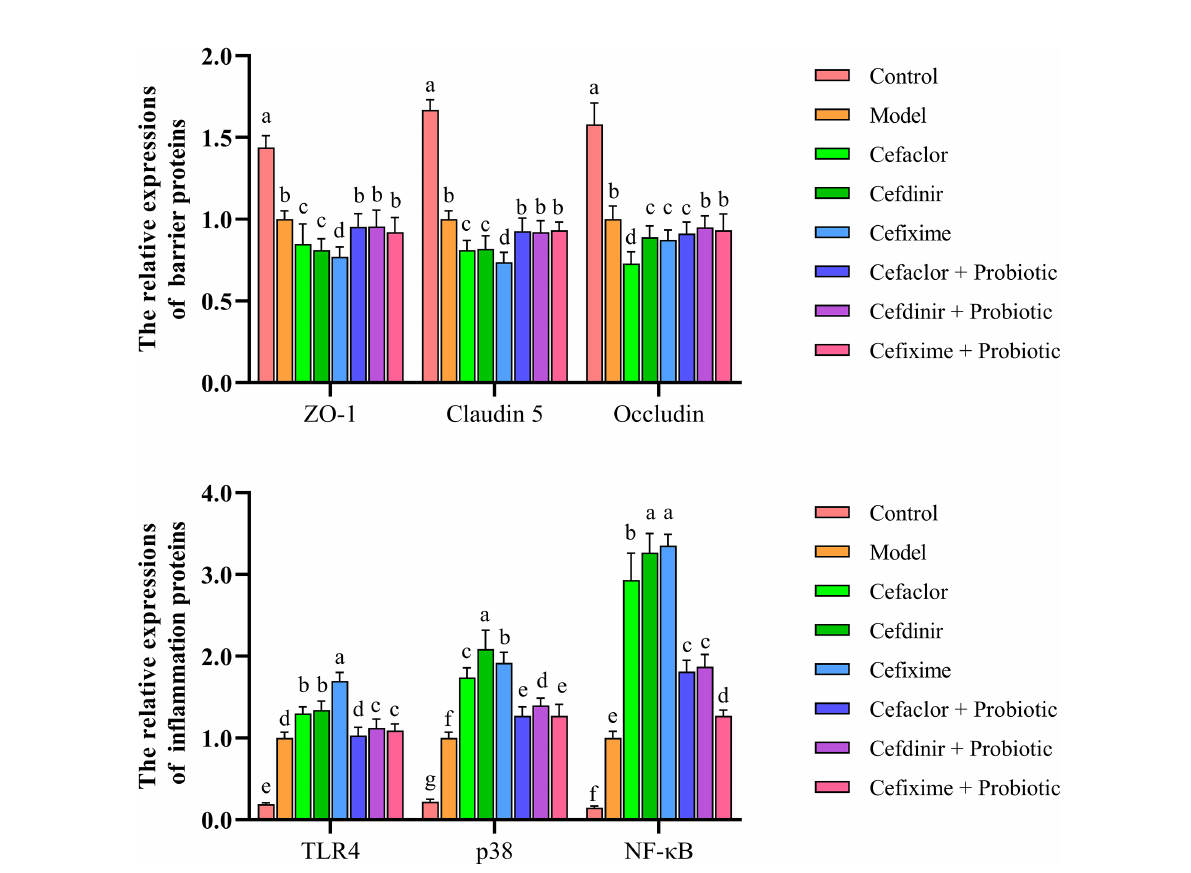
FIGURE 6 Effects of cephalosporins on expressions of ZO-1, Claudin 5, Occludin, TLR4, p38 and NF- k B mRNAs in the lung tissues of Spn-infected mice. Data were showed as mean ± SD. Different letters indicated statistically signi fi cant differences, P